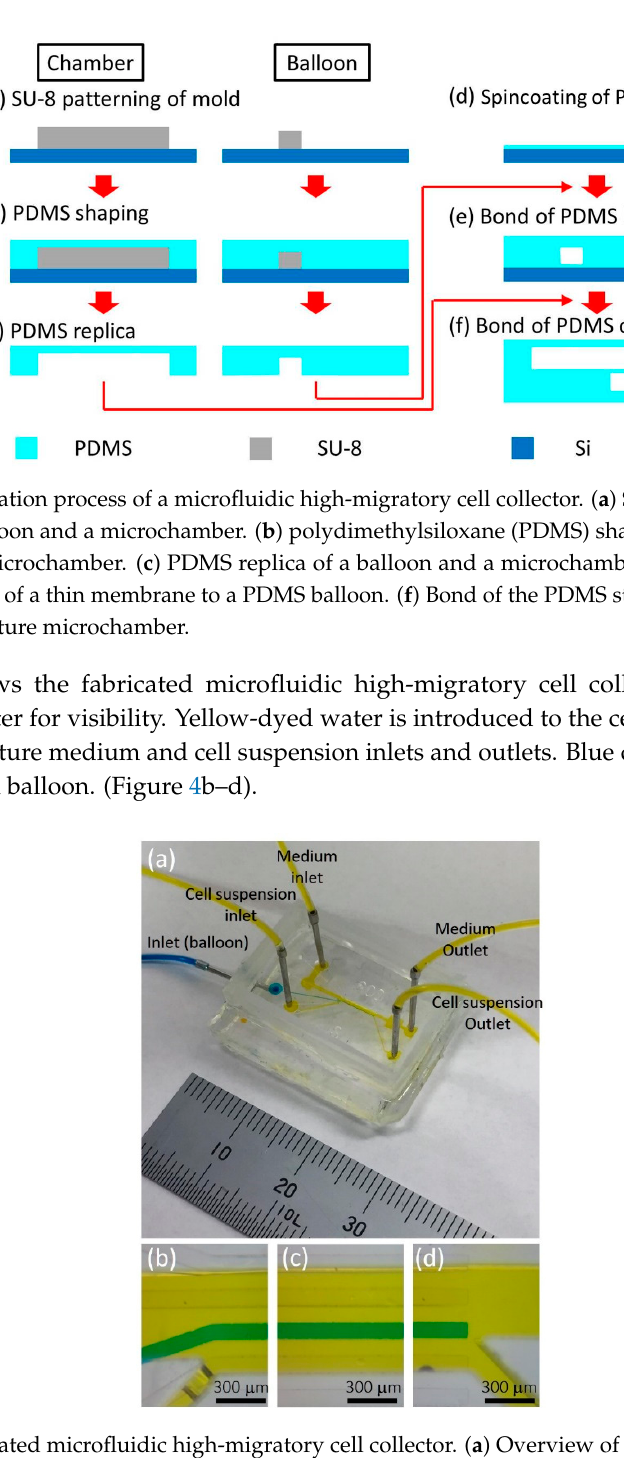
Figure 4. Fabricated microfluidic high-migratory cell collector. ( a ) Overview of the device. Magnified images of ( b ) inlets of culture medium and cell suspension. ( c ) Cell culture microchamber where high-migratory cancer cells are selected. ( d ) Outlets of culture medium and cell suspension.